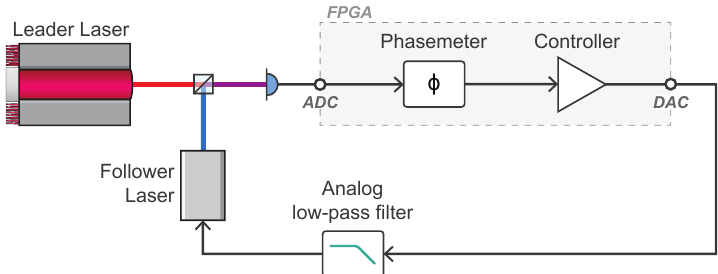
Figure 4. Illustration of the optical and FPGA implemented digital signal processing systems used to offset phase-lock two